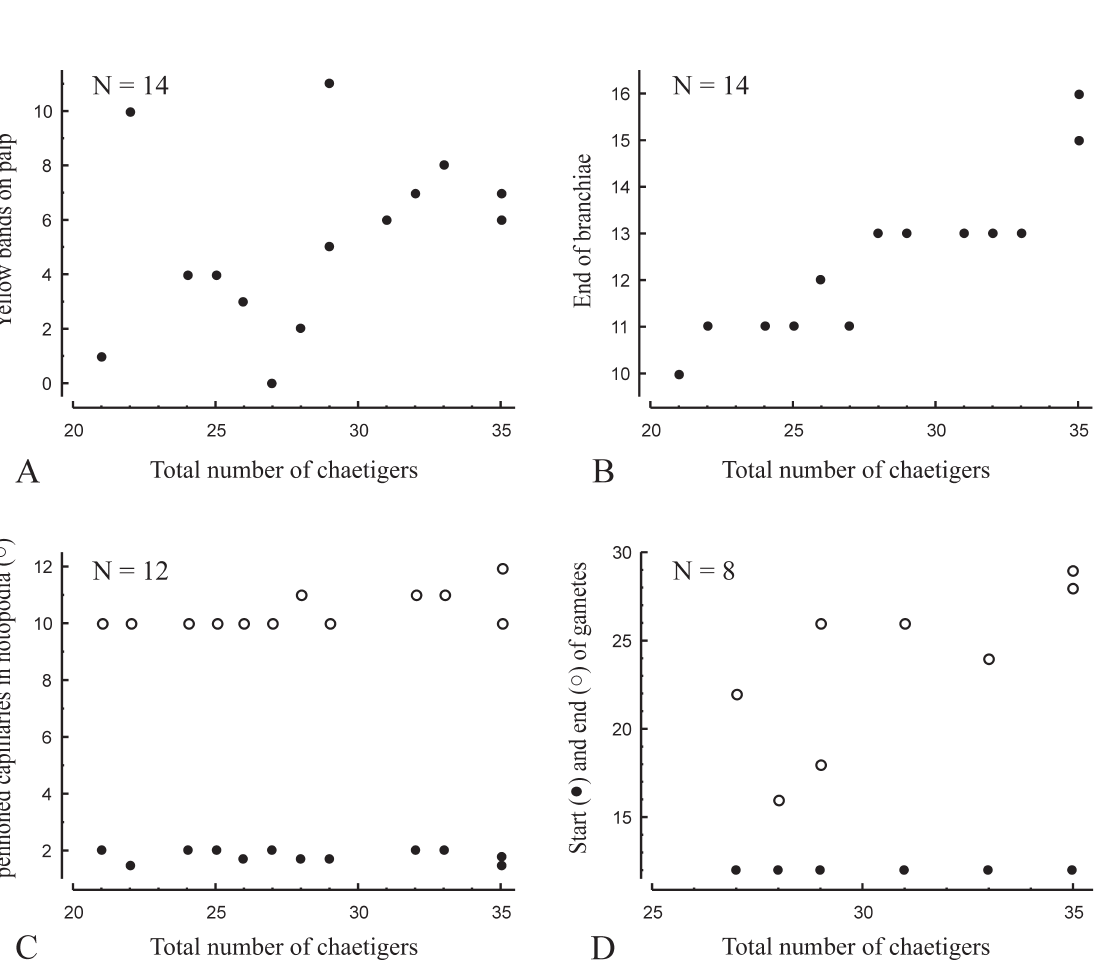
Fig. 14. Adult characteristics of Pseudopolydora kuwaiti sp. nov. A . Relationships between number of yellow bands on palp and total number of chaetigers. B . Relationships between distribution of branchiae (referring to number of the last branchiate chaetiger) and total number of chaetigers. C . Relationships between caruncle length (in chaetiger numbers) and total number of chaetigers, and distribution of pennoned capillaries in notopodia (referring to number of the last chaetiger with pennoned capillaries) and total number of chaetigers. D . Relationships between distribution of gametes (referring to number of the first and the last chaetigers with gametes) and total number of